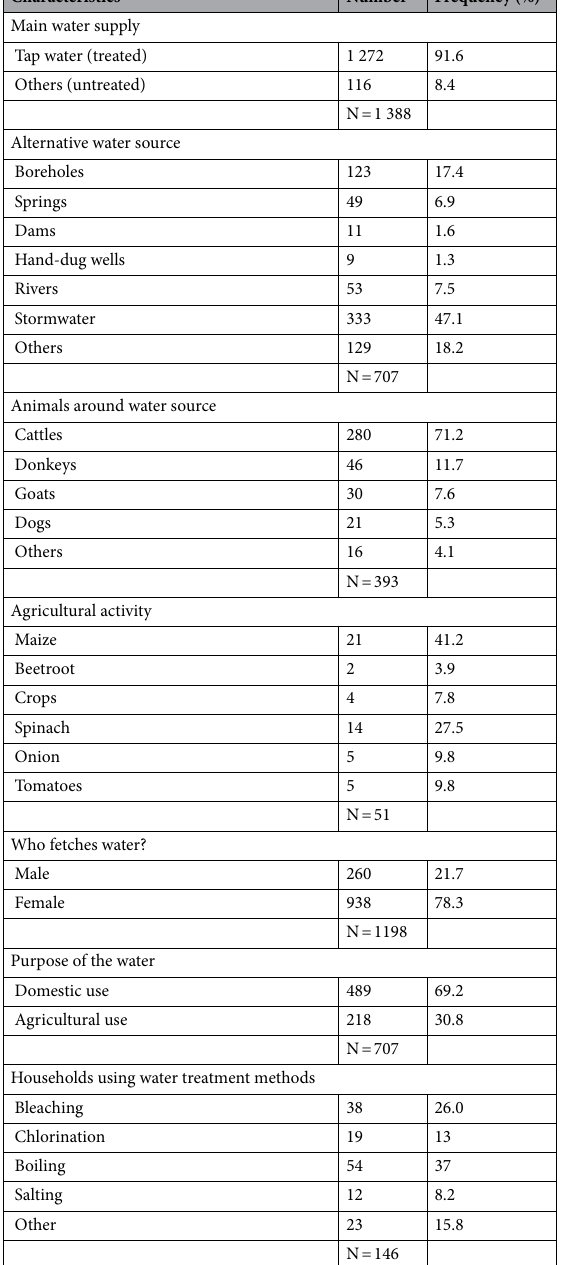
Table 2. Water sources and their usage in the study